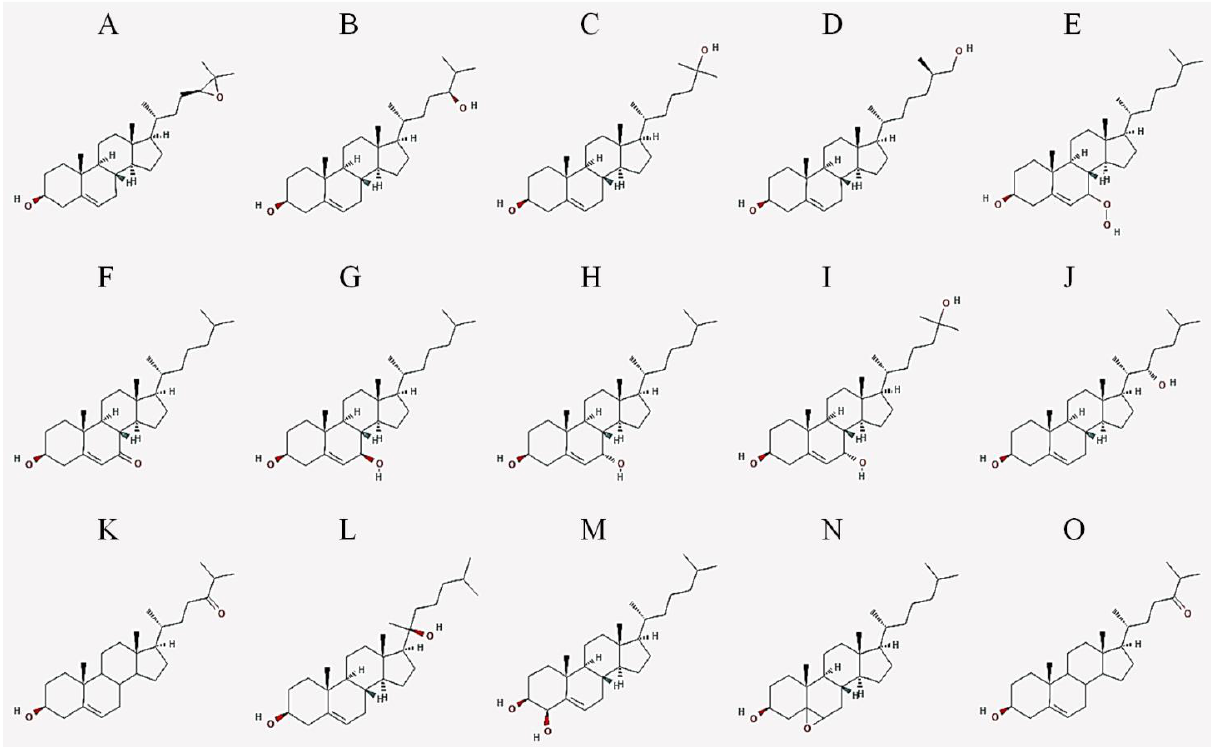
Figure 1. Oxysterol 2D molecules representations. ( A ) 24(S),25-epoxycholesterol; ( B ) 24(S)-hydroxycholesterol; ( C ) 25-hy- droxycholesterol; ( D ) 27-hydroxycholesterol; ( E ) 7-hydroperoxycholesterol; ( F ) 7-ketocholesterol; ( G ) 7β -hydroxycholes- terol; ( H ) 7α -hydroxycholesterol; ( I ) 7α,25 -dihydroxycholesterol; ( J ) 22(S)-hydroxycholesterol; ( K ) 24-oxocholesterol; ( L ) 20(S)-hydroxycholesterol; ( M ) 4β -hydroxycholesterol; and ( N ) 5,6-epoxycholesterol; ( O ) 24-oxocholesterol. Source: Pub- Chem; URL: https://pubchem.ncbi.nlm.nih.gov; last accessed, 5 August 2021. Table 1. Common names of the main oxysterols and their chemical nomenclature.